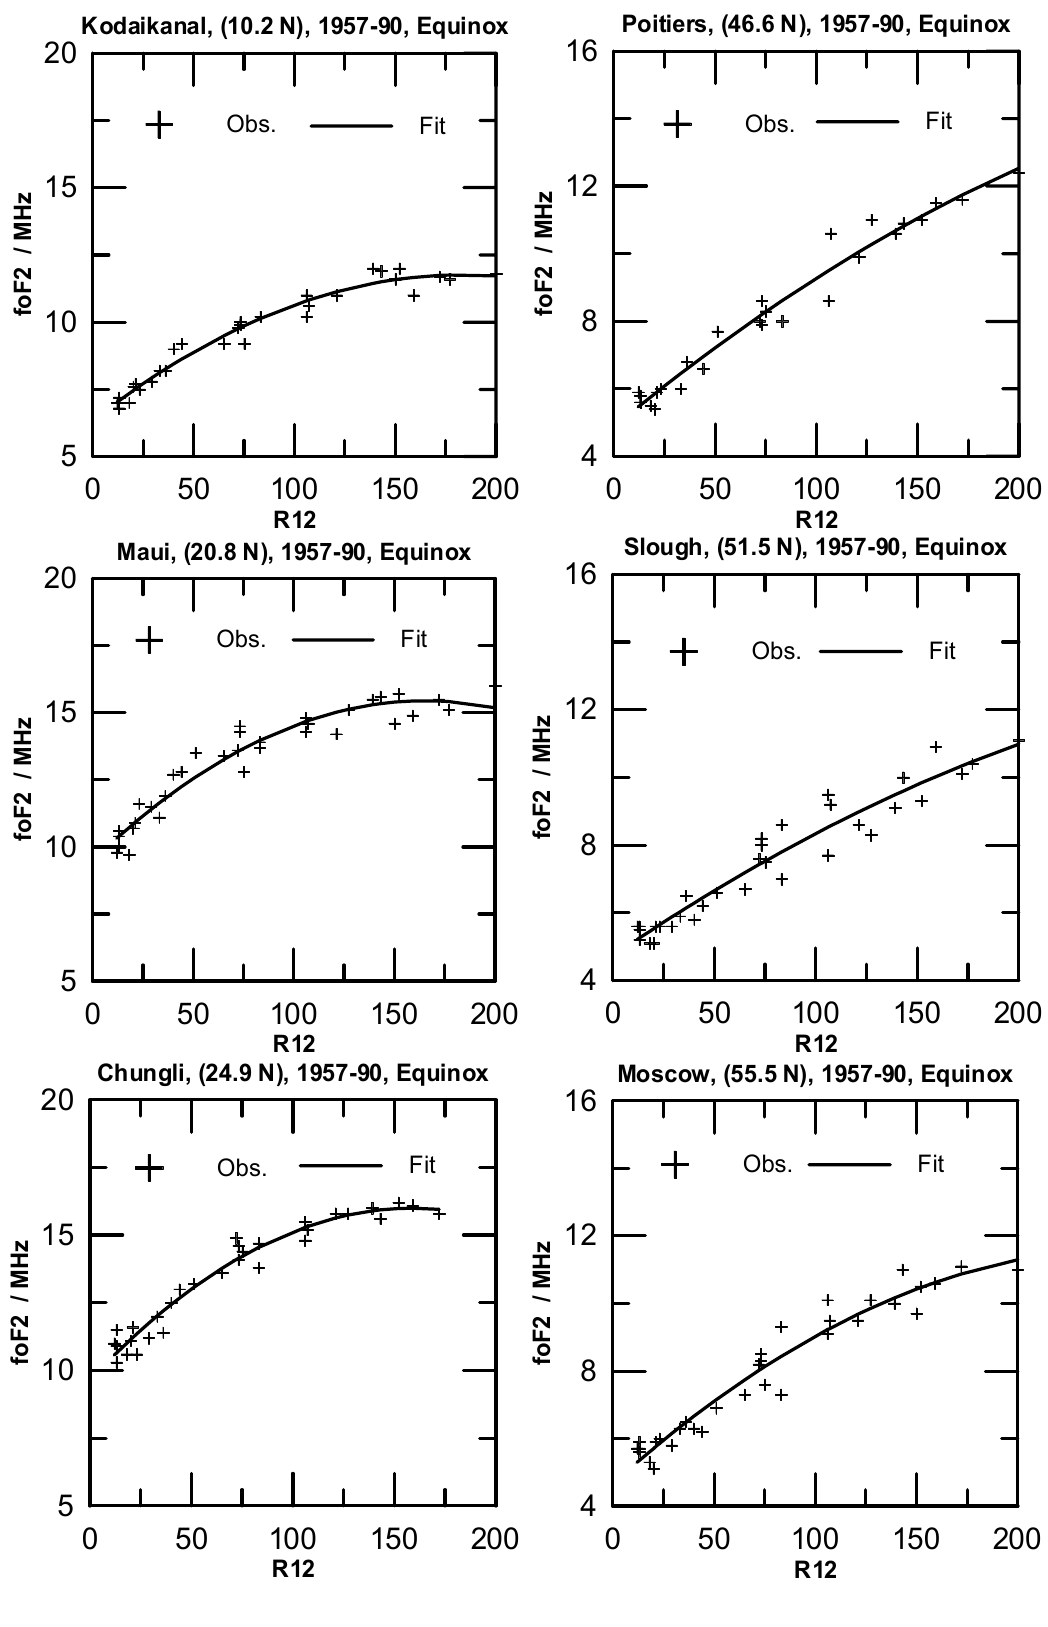
Fig. 3. Same as Fig. 1 but for